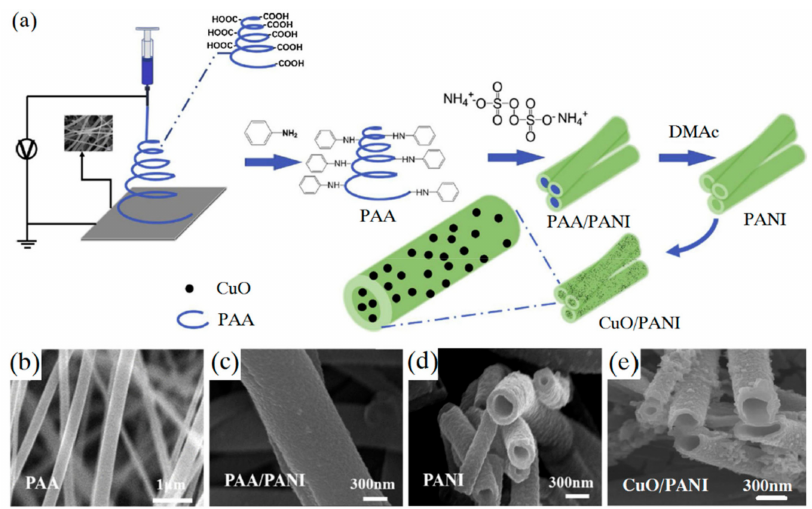
Figure 8. ( a ) The preparation procedure of hollow CuO / PANI hybrid nanofibers; SEM image of PAA nanofibers ( b ), PAA hybrid nanofiber covered by PANI ( c ), the hollow PANI nanofibers ( d ) and